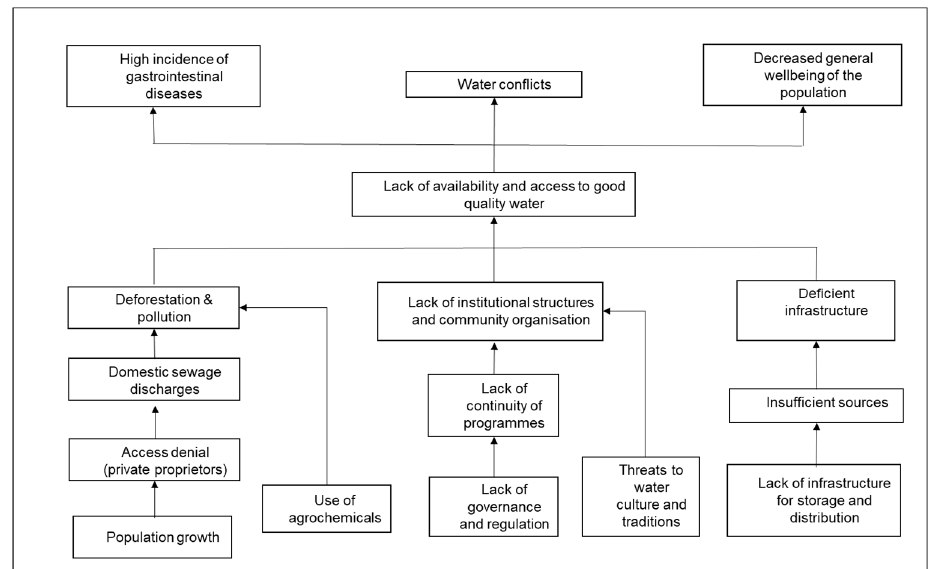
Figure 4 . Perceptions of the problem of water by ICs in Los Altos, Chiapas, Mexico . Figure 4. Perceptions of the problem of water by ICs in Los Altos, Chiapas,